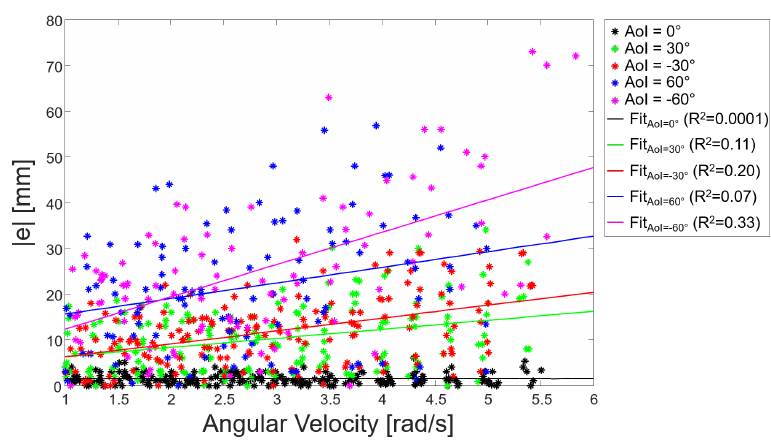
Figure 10. The absolute values of the errors e computed by the IR-ToF proximity sensor during all dynamic experiments are reported with a different color for each AoI value. Furthermore, for each AoI value, a colored line showed the trend of the absolute errors with respect to the angular velocity.